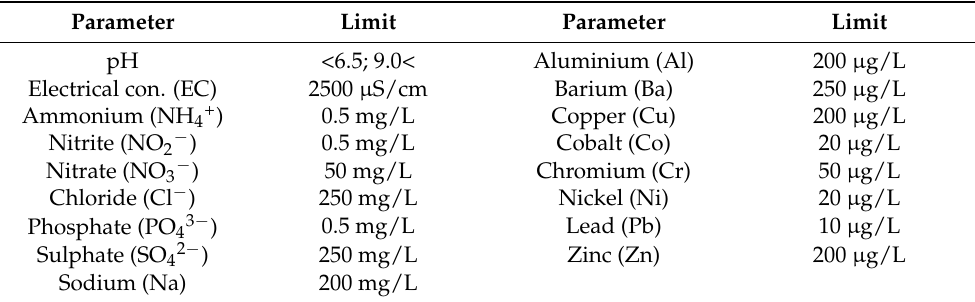
Table 1. Contamination limit of the investigated parameters according to Hungarian legislation (Joint Regulation KvVM-EüM-FVM No 6/2009 (IV.